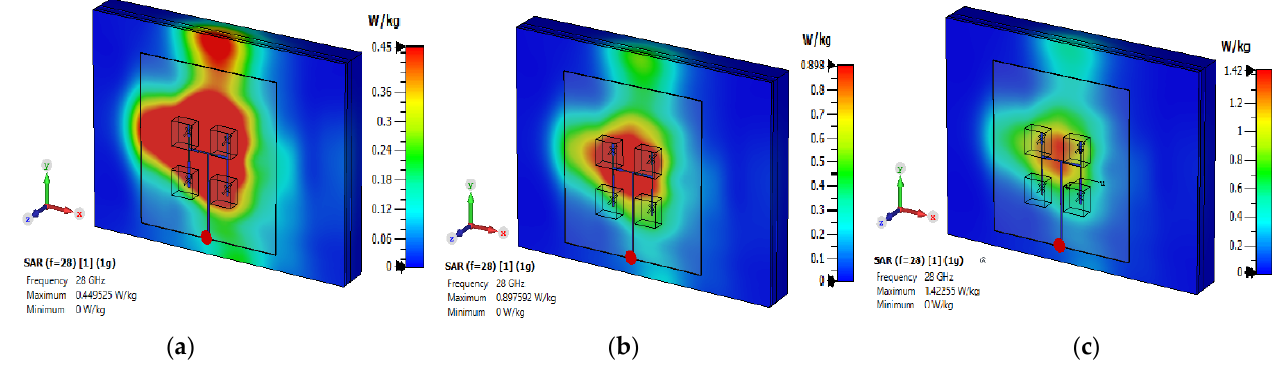
Figure 15. The SAR of the DRA array for a 1-gram tissue and input power of ( a ) 15 dBm, ( b ) 18 dBm, ( c ) 20 dBm.